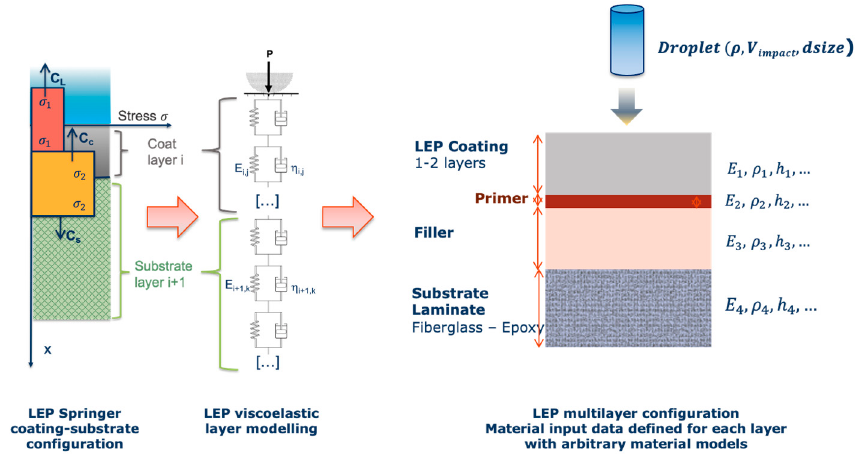
Figure 12. LEP configuration considering viscoelastic material models, multilayer and 1D droplet impact event. Table 1. Initial Reference Input data used for the impact modelling of RET